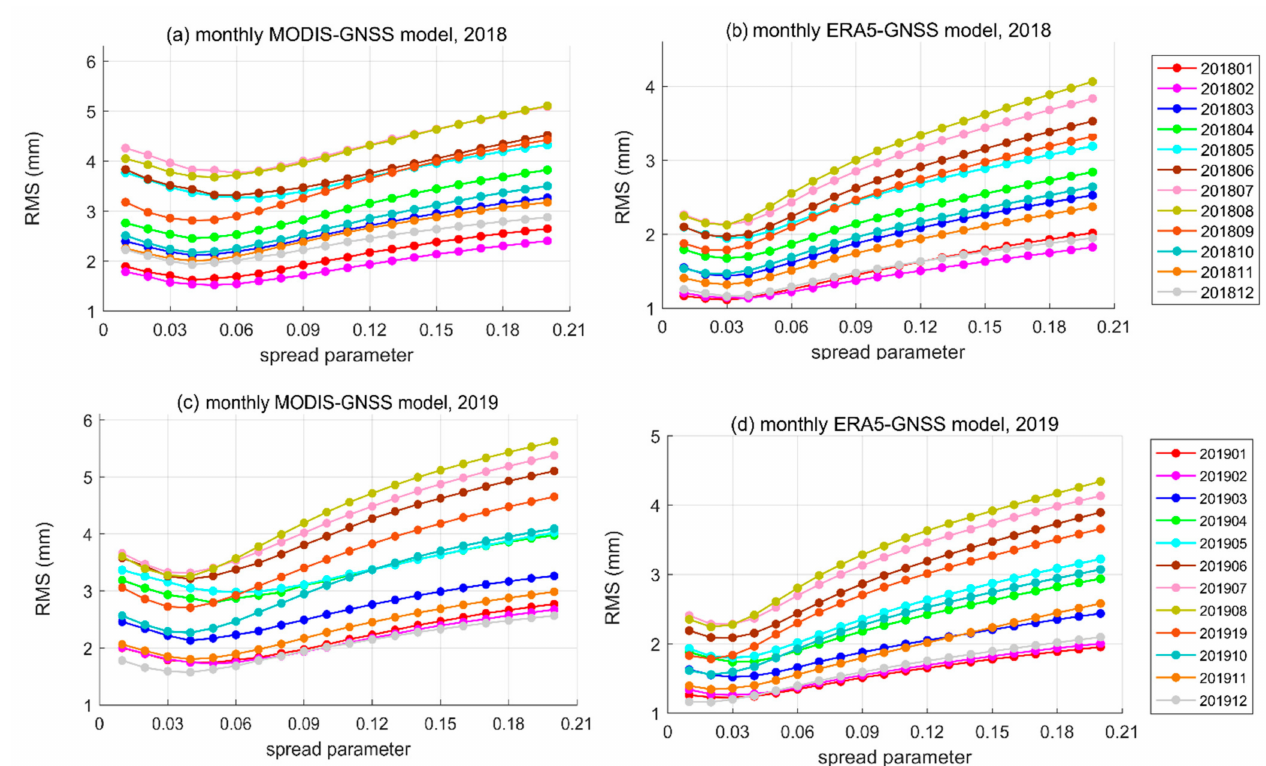
Figure A3. Monthly model performance against spread parameter